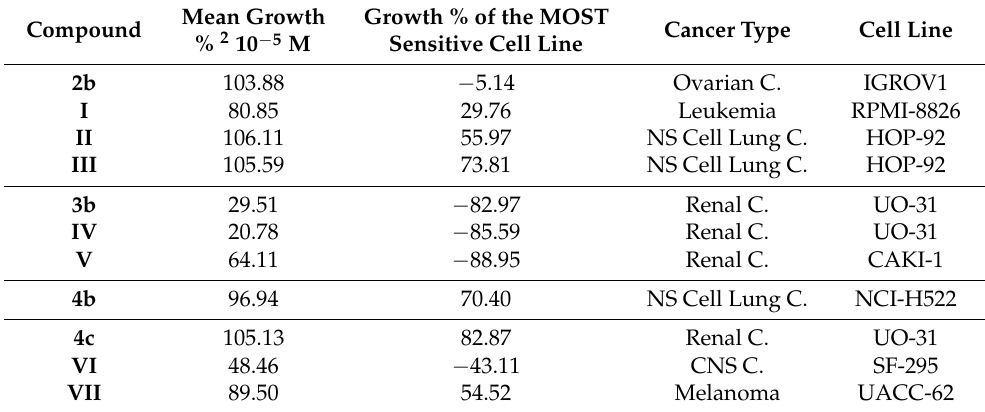
Table 4. Overview of the one-dose 10 − 5 M assay of new compounds 2b , 3b , 4b and 4c in comparison with their analogs I – VII 1